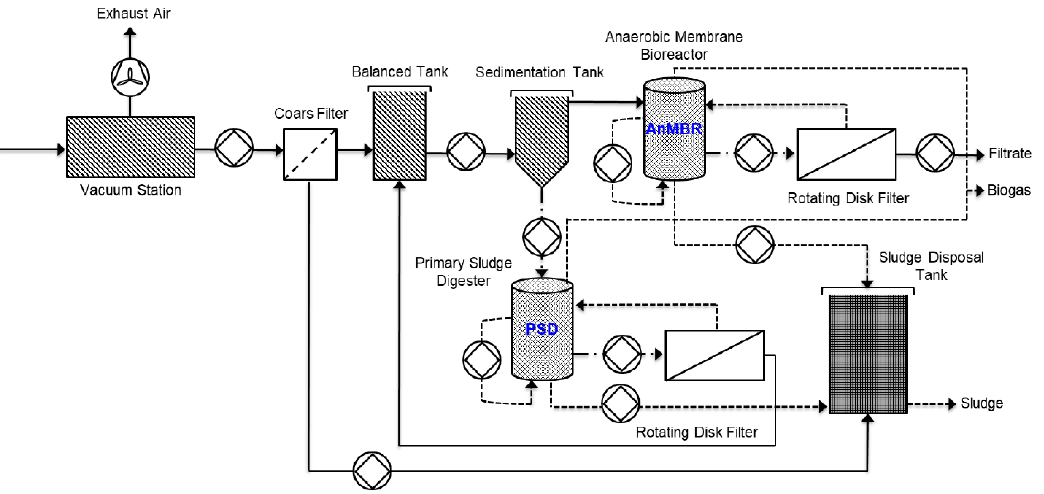
Figure 1. Schematic diagram of the decentralized wastewater treatment system (DWTS) with a primary sludge digestor (PSD) and anaerobic membrane bioreactor (AnMBR).